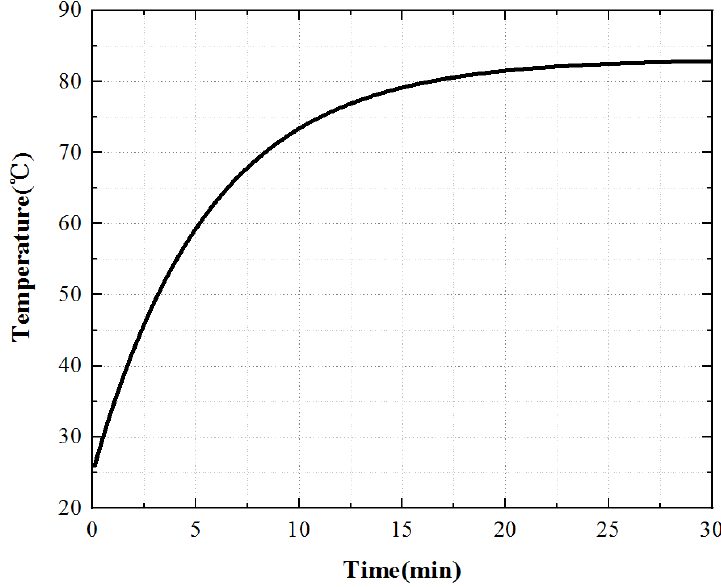
Figure 11. Temperature rise characteristic curve of the stator core.